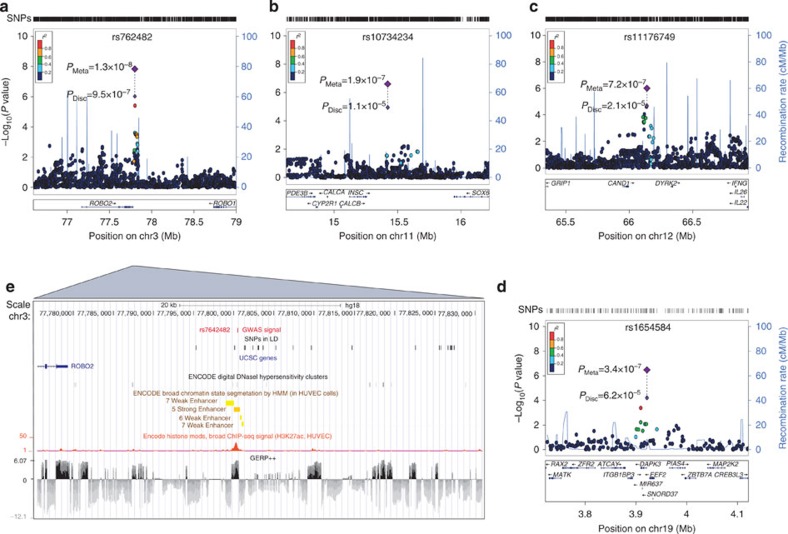
Association plots for early expressive vocabulary signals.For the 3p12.3 (a), 11p15.2 (b), 12q15 (c) and 19p13.3 (d) region, SNPs are plotted with their discovery -log10
P value as a function of the genomic position (hg18). P values were generated from weighted linear regression of the rank-transformed vocabulary score (15–18 months of age) on allele dosage. P values of discovery SNPs taken forward to the follow-up analysis are denoted by a small purple diamond (PDisc) and their combined meta-analysis P value (PMeta) is represented by a large purple diamond. The local linkage disequilibrium (LD) structure near the associated region is reflected by recombination rates estimated from Hapmap CEU (phase II). SNPs are coloured on the basis of their correlation with the lead signal (based on pairwise LDr2 values). (e) Detailed annotation of the genomic region at 3p12.3 using the UCSC Genome Browser (hg18) including rs7642482 and SNPs in LD (±500 kb, LDr2>0.3, Hapmap). Tracks for ENCODE digital DNaseI hypersensitivity clusters, ENCODE histone modifications and chromatin state segmentation in umbilical vein endothelial cells (HUVEC), as well as Genomic Evolutionary Rate Profiling (GERP++) scores (lifted from hg19) are included.